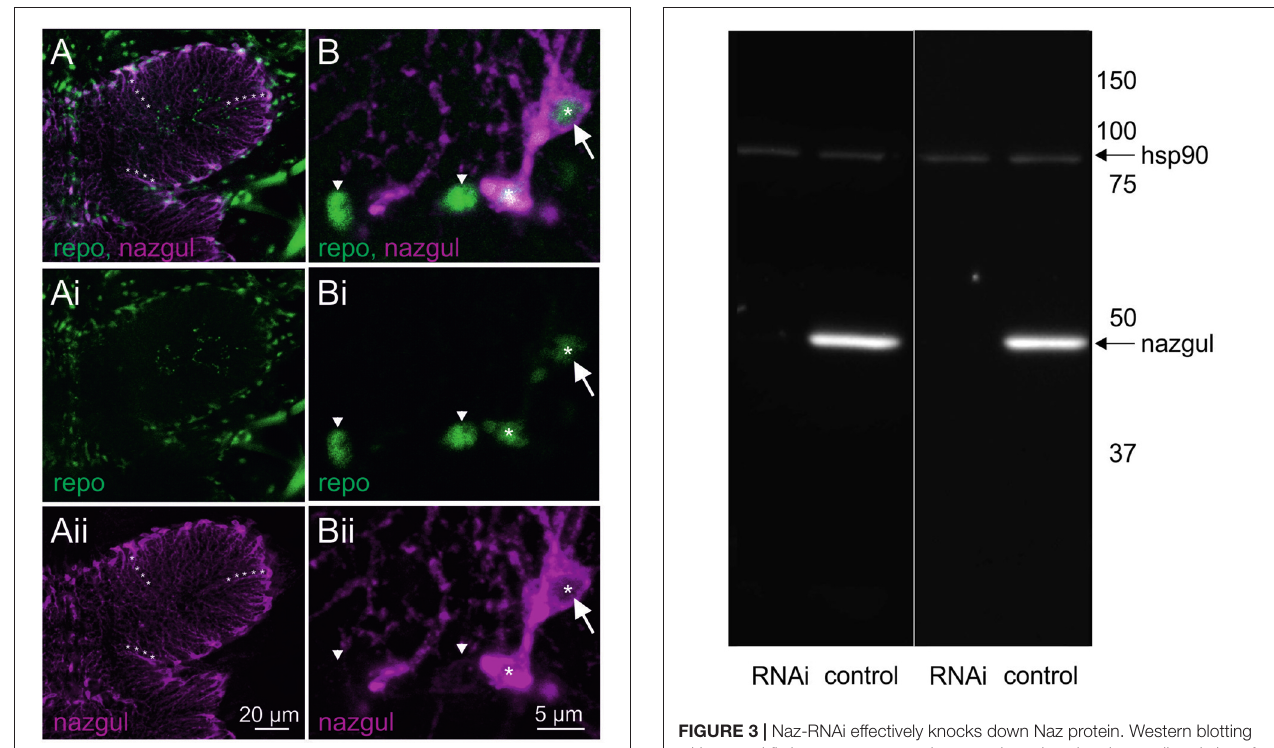
FIGURE 2 | Naz localizes to the cytosol of a subset of Repo positive glial cells. (A) Maximum projection view of a representative confocal image stack taken from double immunolabeling of Naz (magenta) and Repo (green) thoracic flight motor neuropil. Lines of white asterisks demark arbors of Naz positive cells that extend from the neuropil border into the center of the neuropil. The individual labels for Repo and Naz are shown in (Ai,Aii) . (B) Selective enlargement of a representative single optical section shows four Repo positive glial cell nuclei, two belonging to Naz negative (arrowheads) and two to Naz positive glial cells. Only a subset of Repo positive glial cells is Naz positive. Naz protein is localized cytosolic through the soma and the arbors of these glial cells. Naz protein is not localized to the nucleus as apparent from the absence of Naz immunopositive label in single optical sections through Repo positive nuclei (white arrow). Please note that the lower Repo-positive glial cell nucleus is out of focus in this section, and thus co-labels with Naz-positive cytosol. The individual labels for Repo and Naz are shown in (Bi,Bii) .